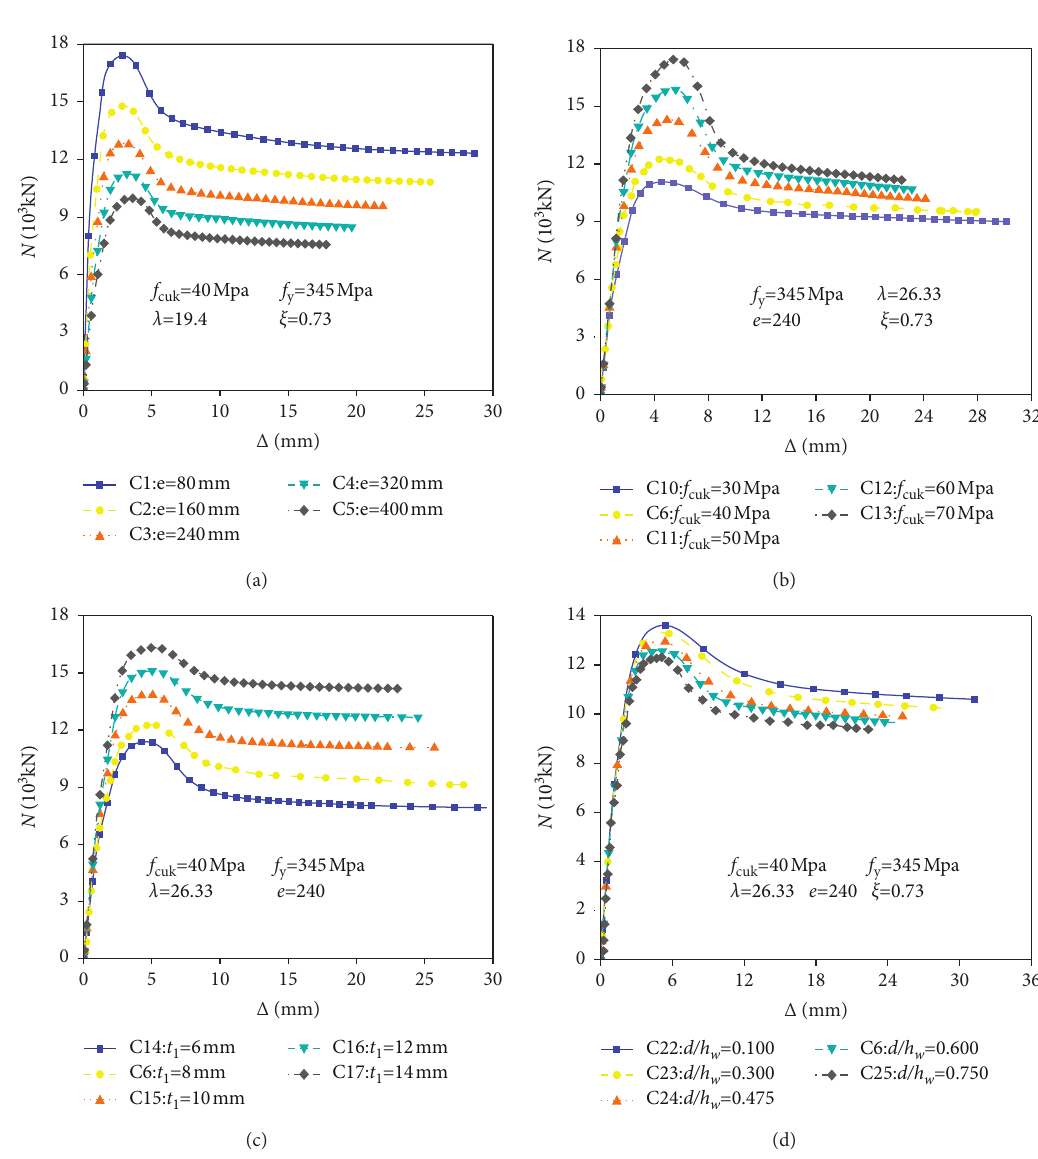
cuk . (c) t 1 . (d) d / h w